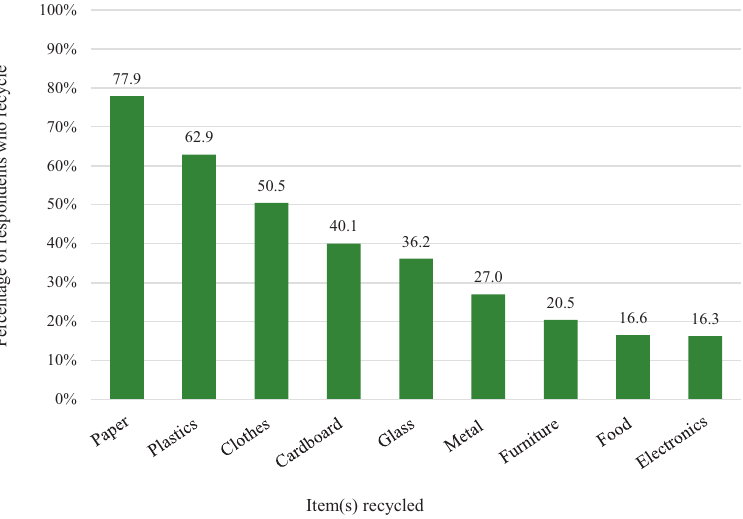
Figure 2. Percentage of respondents who recycle various